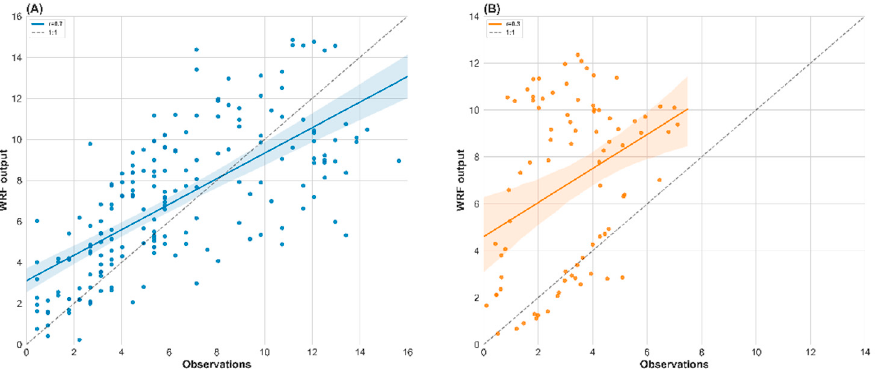
Figure 12. ( A ) WRF 10 m winds against RAWS stations, solid blue line indicates regression line and a 95% confidence interval (shaded), dotted line indicates 1:1. ( B ) WRF 10 m against Stirling City and Red Hill Lookout PG&E stations with regression line and confidence interval in orange.